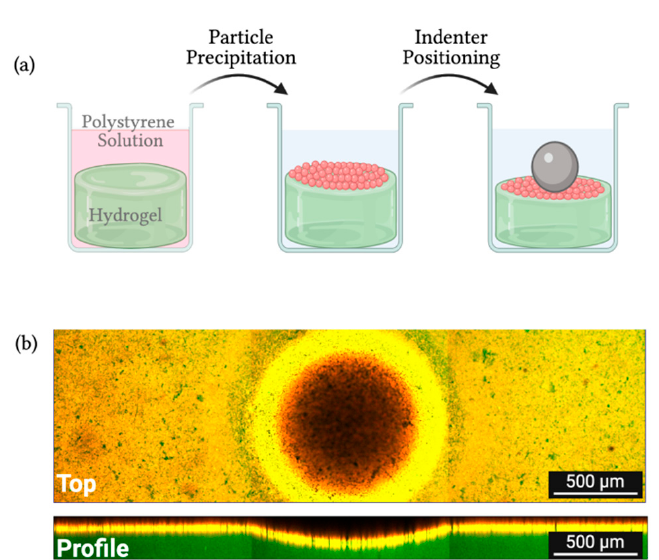
Figure 4. Setup for indentation experiment. ( a ) Bioprinted constructs were labeled with fluorescein sodium salt, while red polystyrene particles were deposited on its surface. Spherical ceramic indenters were positioned on the surface of the constructs, generating an indentation depth. ( b ) Indentation depths were measured by visualizing images obtained by the gel indented surface. Scale bar represents 500 μ m.